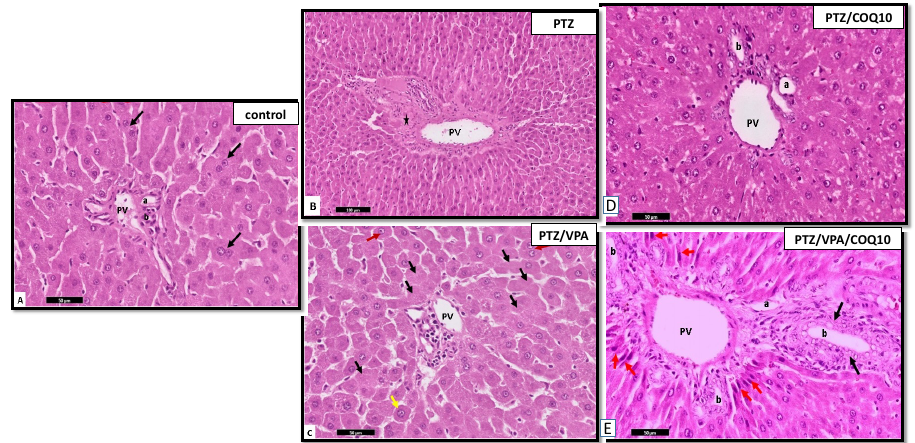
Figure 10. Photomicrographs of the rat liver sections at the portal area of all of the rats groups. Control group showing the portal vein (PV), Bile ducts ( b ) and hepatic artery ( a ). Some are binucleated (black arrow) ( A ). PTZ group showing the dilated portal vein (PV). Notice the heavy cellular infiltration (*) ( B ). ( C ) PTZ/VPA group showing a few normally arranged hepatocytes (red arrow); some of them show the loss and fading of nuclei (karyolysis) (Black arrow) and megalocytes (yellow arrow). ( D ) PT Z/COQ10 showing the hepatocytes with normal architecture near to the control. ( E ) PTZ/VPA/COQ10 showing the proliferating bile duct (black arrow) and the presence of newly formed hepatocytic cells with relatively rounded to elongated, large, dark nuclei (red arrow) ( E ). H&E stain/scale bar (( A – I )50 µ m).